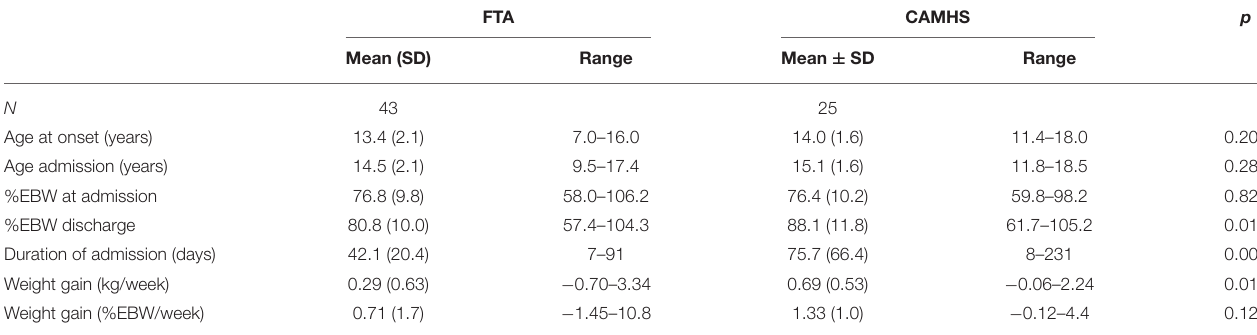
TABLE 1 | Participant characteristics of the sample during